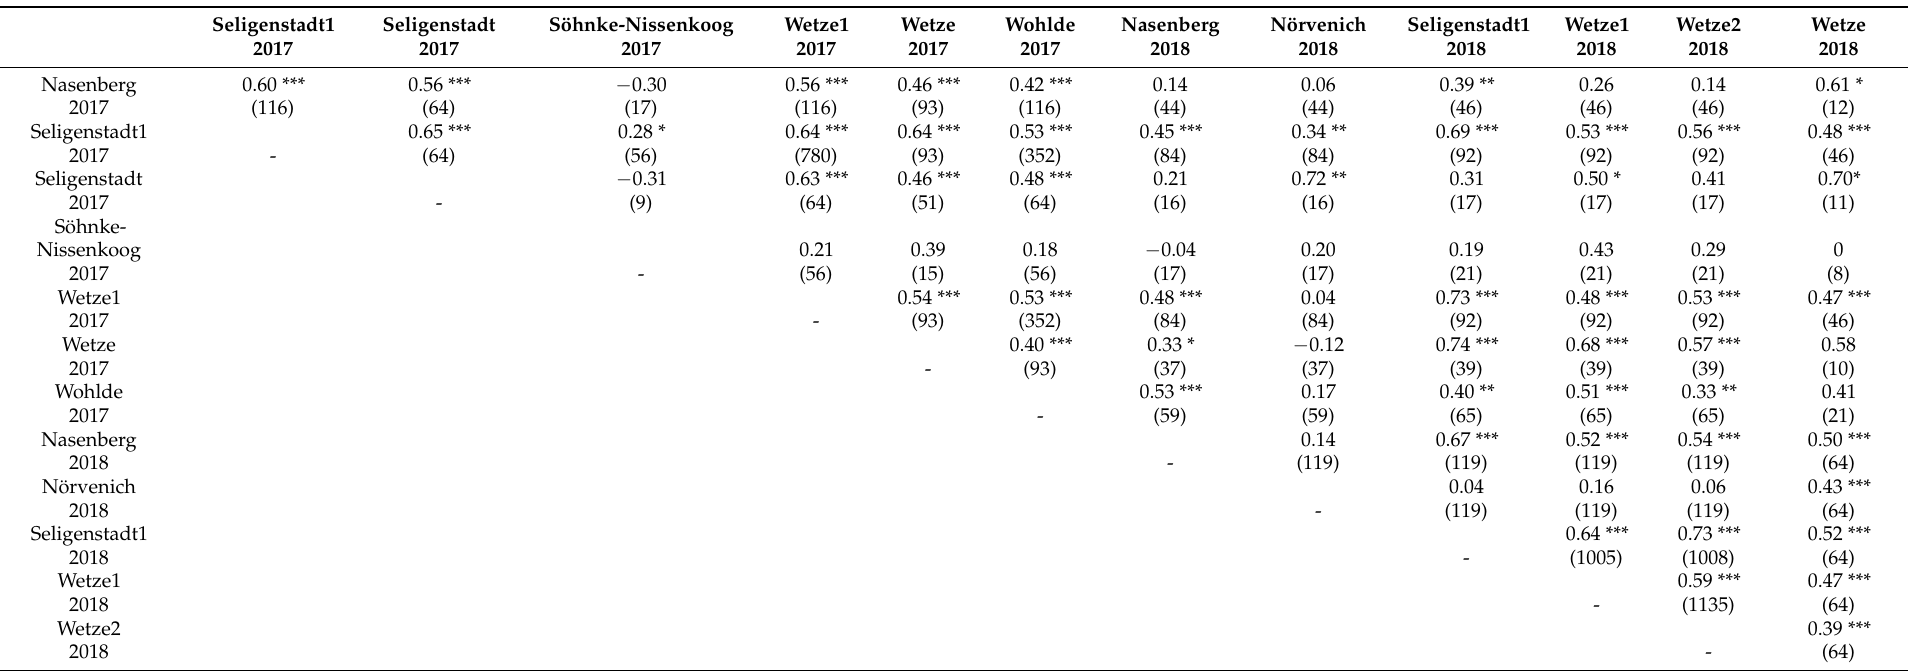
Table 3. Pearson correlation of leaf rust scores observing overlapping genotypes of pairwise compared field environments, while the number of overlapping genotypes is given in